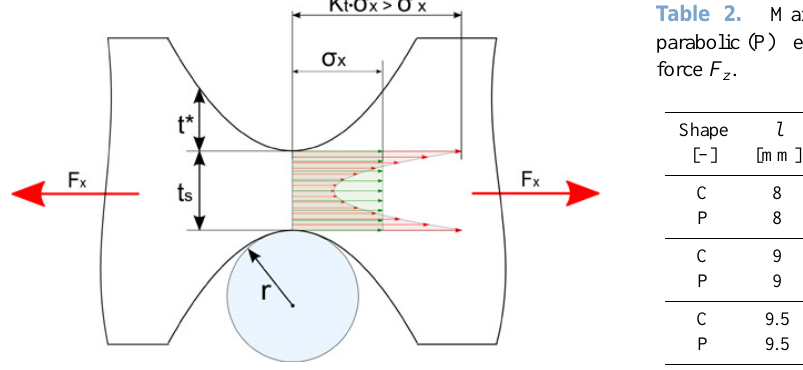
Figure 3. Stress concentration at flexure hinges due to notch e ff ect.